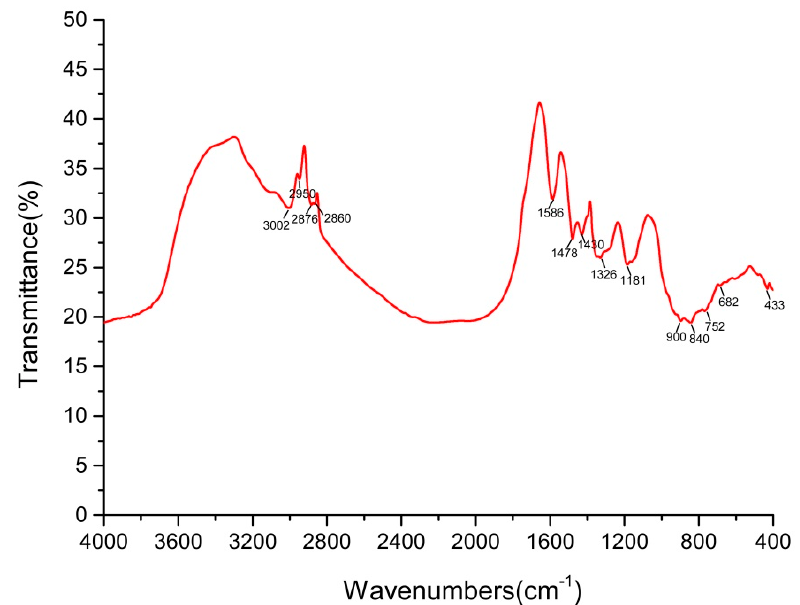
Figure 7. The FTIR spectrum of SeNPs synthesized by isolate YC801.